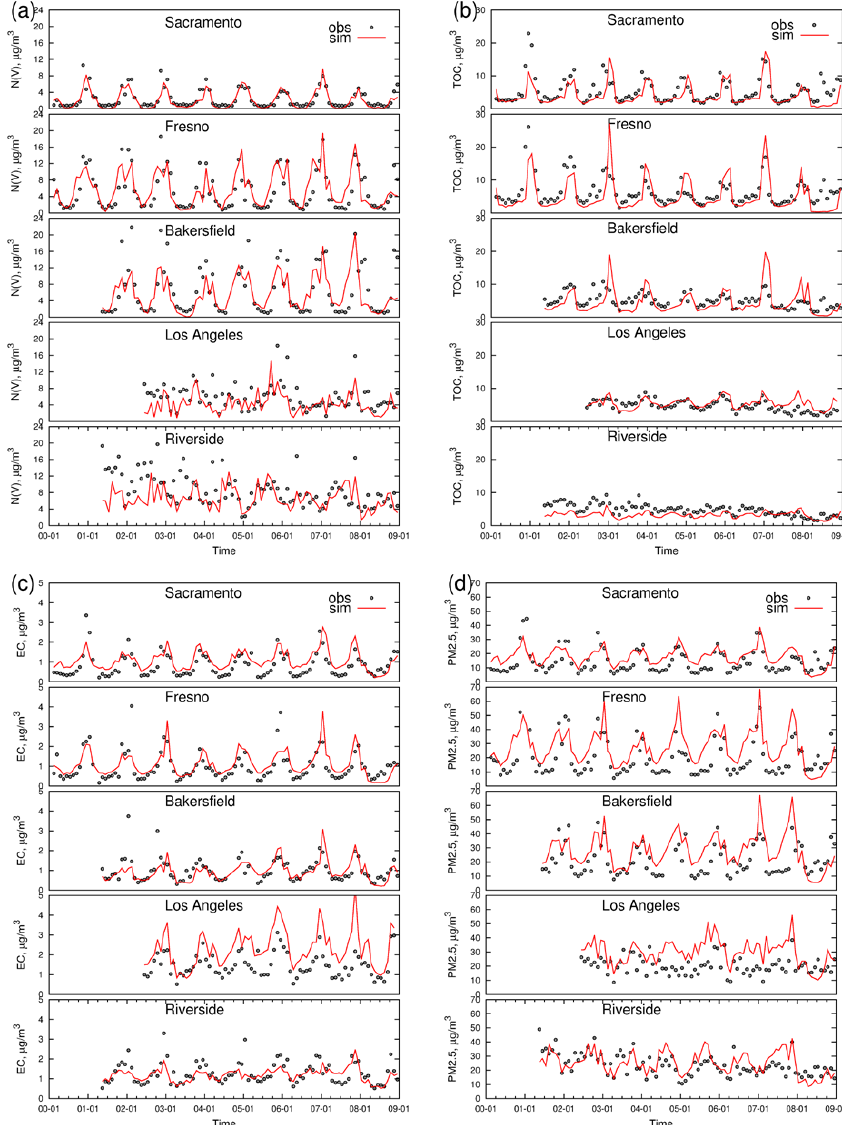
Figure 6. Predicted (red lines) vs. observed (dark dots) monthly average PM 2 . 5 nitrate (a) , OC (b) , EC (c) , and PM 2 . 5 total mass (d) at Sacramento, Fresno, Bakersfield, Los Angeles, and